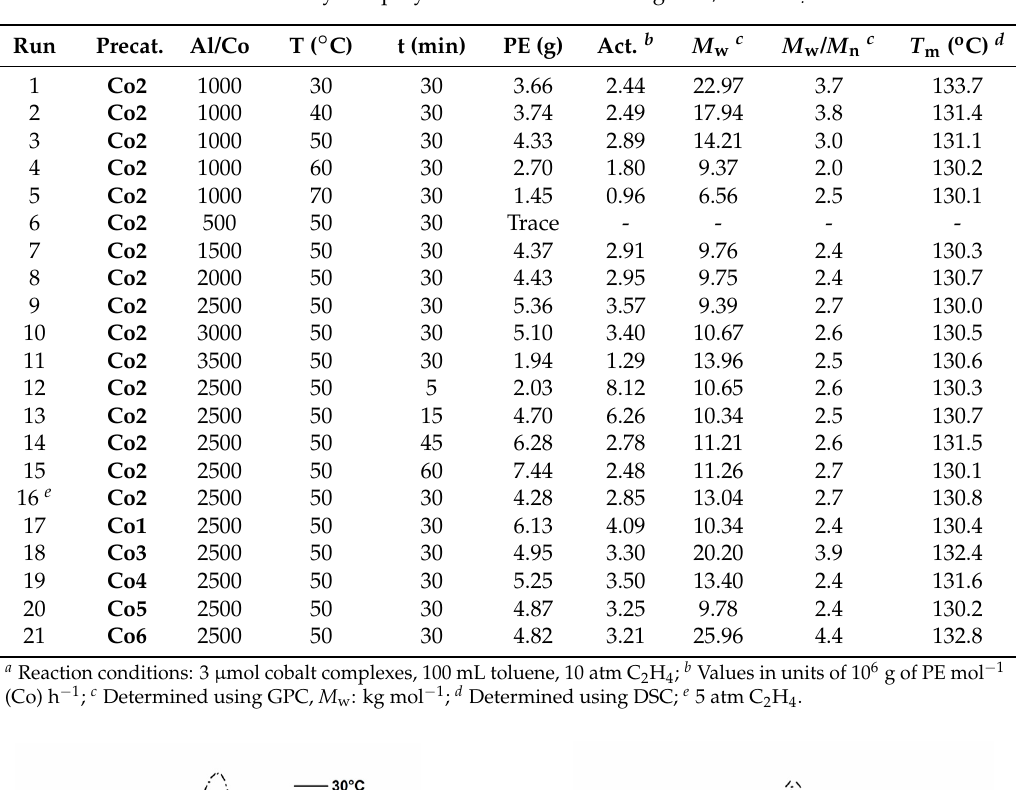
Table 2. Ethylene polymerization results using Co2 / MAO a.